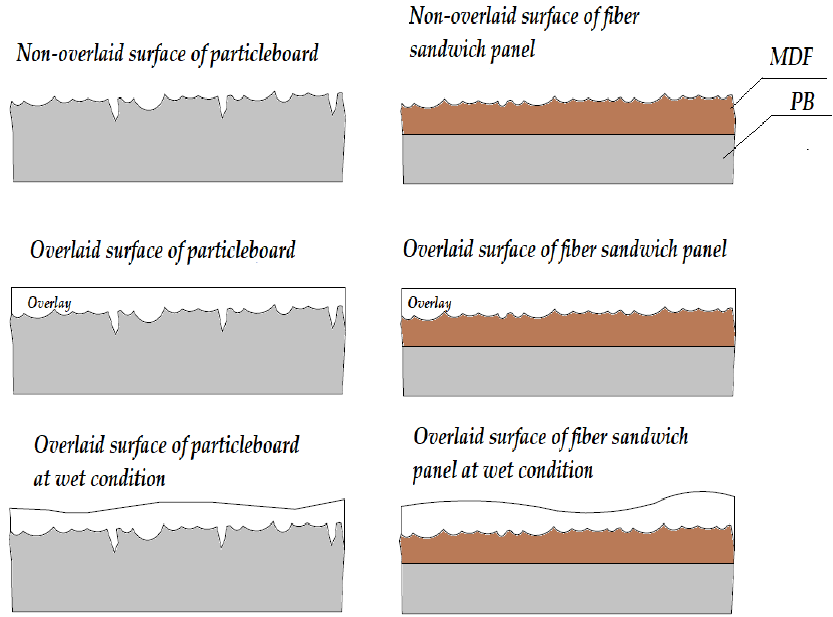
Figure 5. Penetration of humidity on surface characteristics.